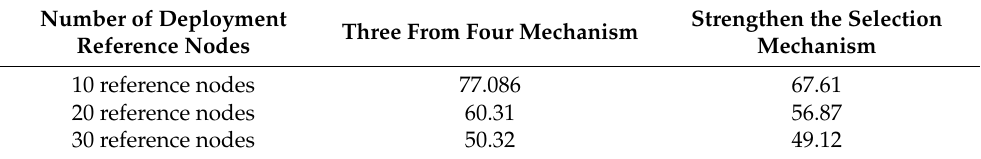
Table 2. Comparison of conditions added and choosing three from four